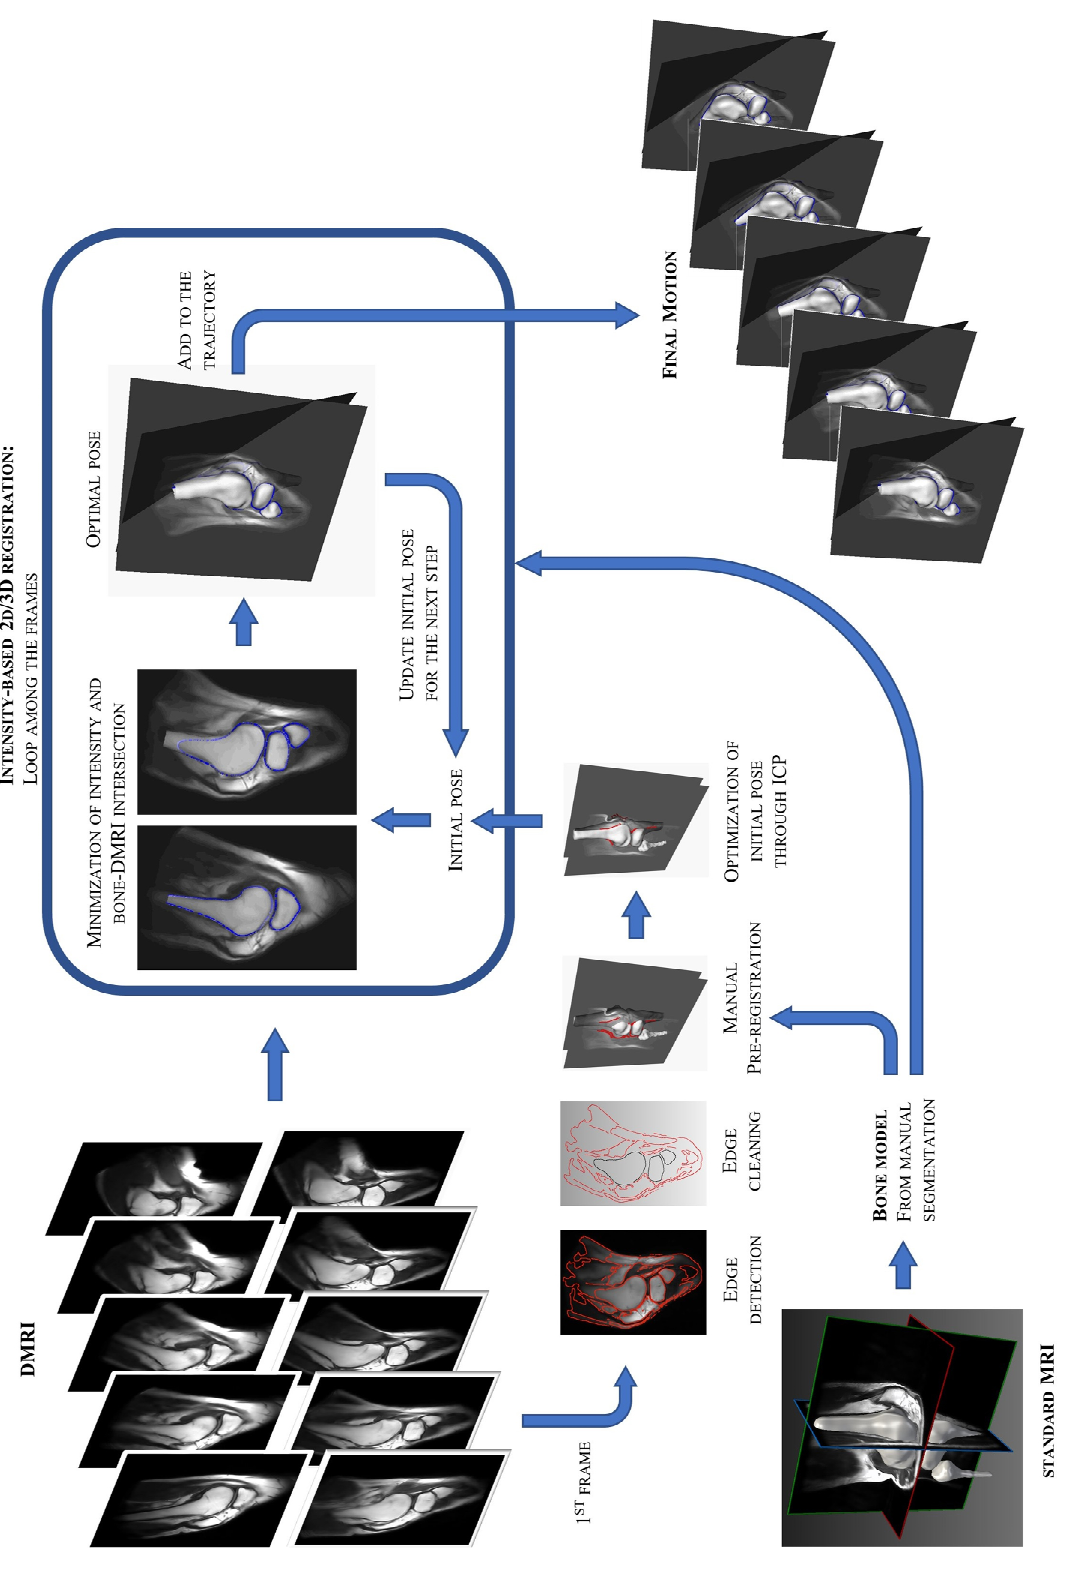
Figure 3. Schematic representation of the registration process to the reconstruction of the knee kinematics from DMRI.